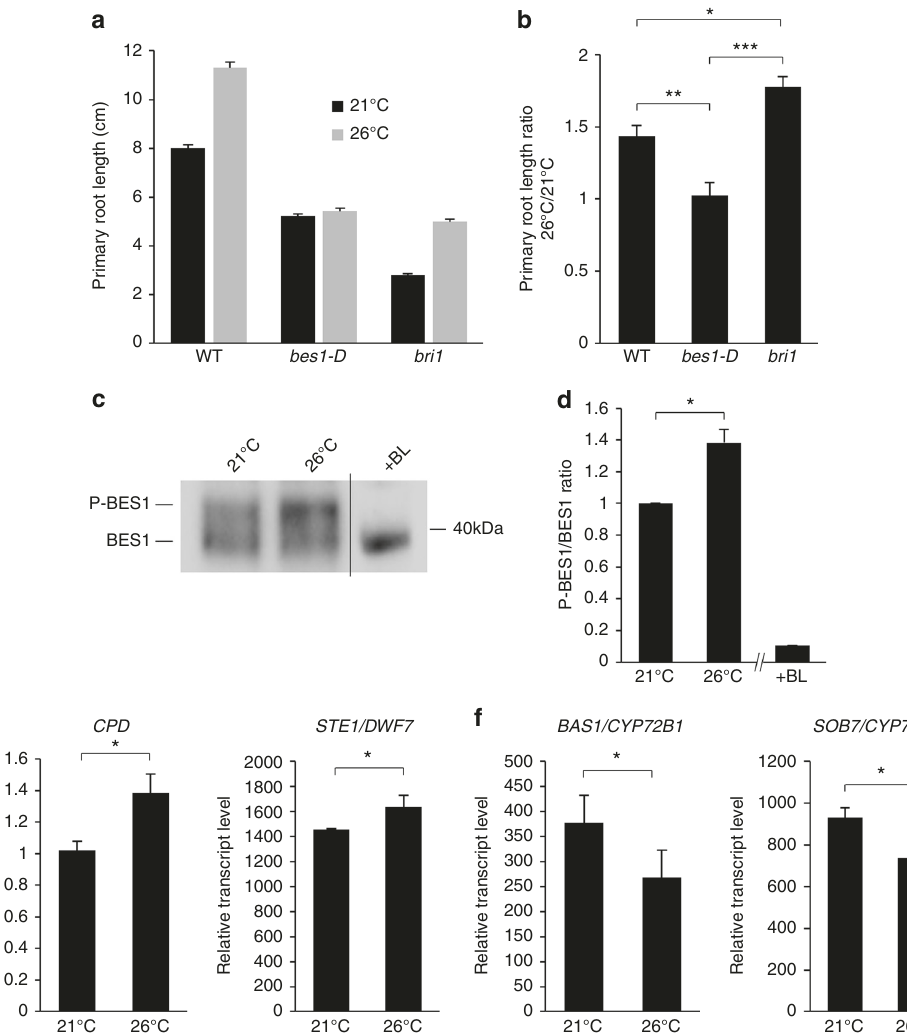
Fig. 4 Brassinosteroid signaling regulates root responses to elevated ambient temperature. a Primary root length of 15-day-old wild-type ( WT ) or brassinosteroid-related mutant plants grown at 21 or 26 °C (mean ± s.d., n = 25). b Ratio of primary root length from plants grown at 26/21 °C as in a (mean ± s.d., n = 3). The asterisks indicate a statistically signi fi cant difference (Kruskal – Wallis; * P < 0.01; ** P < 0.001; *** P < 0.0001). c Western blot analyses monitoring the phosphorylation state of BES1 in wild-type plants grown at 21 or 26 °C using anti-BES1 antibodies. A root protein extract from plants treated with brassinolide ( BL ) is used as a control for BES1 dephosphorylation. A representative blot is shown. d Ratio of phosphorylated BES1 ( P-BES1 ) over BES1 levels (mean ± s.d., n = 4). The asterisk indicates a statistically signi fi cant difference (Mann – Whitney; * P < 0.01; ** P < 0.001; *** P < 0.0001). e mRNA accumulation of the brassinosteroid feedback-regulated CPD and STE1/DWF7 genes in roots from wild-type plants grown at 21 or 26 °C (mean ± s.d., n = 3). The asterisk indicates a statistically signi fi cant difference (Mann – Whitney, P < 0.01). f mRNA accumulation of the BAS1/ CYP72B1 and SOB7/CYP72C1 brassinosteroid metabolism genes in roots from wild-type plants grown at 21 or 26 °C (mean ± s.d., n = 3). The asterisk indicates a statistically signi fi cant difference (Mann – Whitney, P <